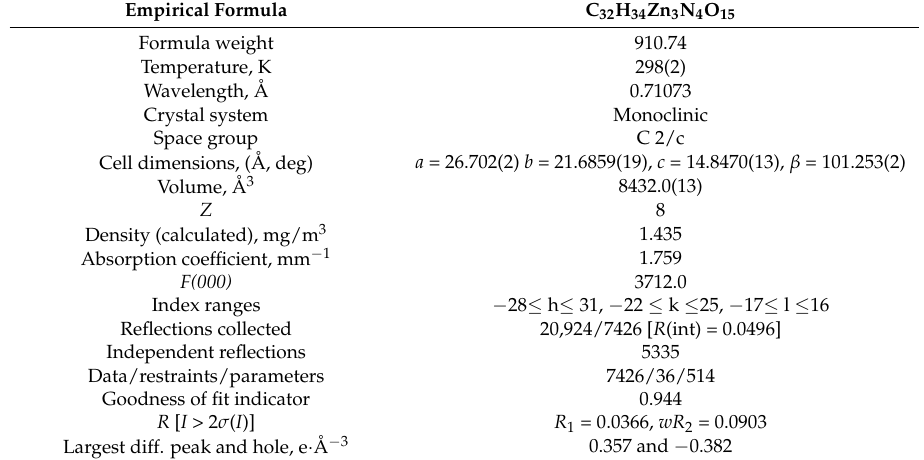
Table 1. Crystallographic data and collection parameters for the Zn II coordination compound. Empirical Formula